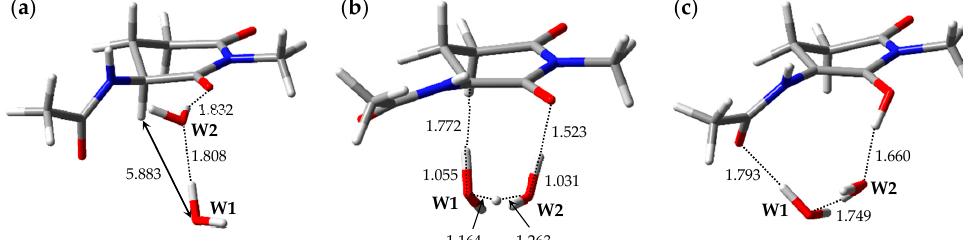
Figure 4. Optimized geometries of the enolization system in Pathway 3: ( a ) 3-RC ( φ = − 120°, ψ = − 159°, χ 1 = − 179°, χ 2 = − 52°); ( b ) 3-TS ( φ = − 159°, ψ = − 160°, χ 1 = − 176°, χ 2 = − 49°); and ( c ) 3-PC ( φ = − 127°, ψ = − 170°, χ 1 = − 159°, χ 2 = − 47°). The selected interatomic distances are shown in Å.